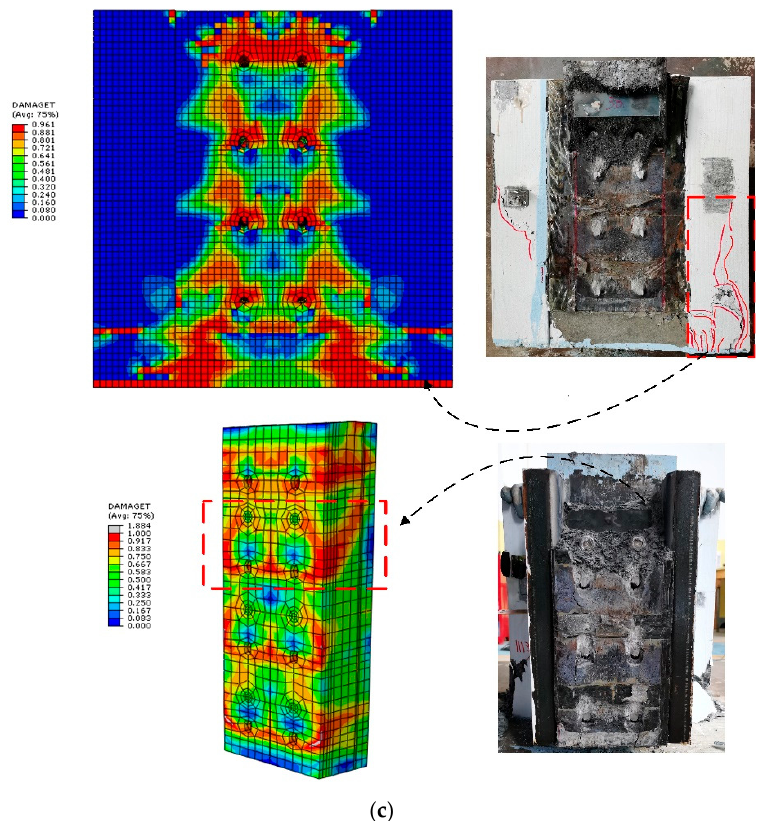
Figure 22. The failure mode of FEM simulation and test: ( a ) Shear reinforcement; ( b ) Stud; ( c ) Concrete and UHPC.